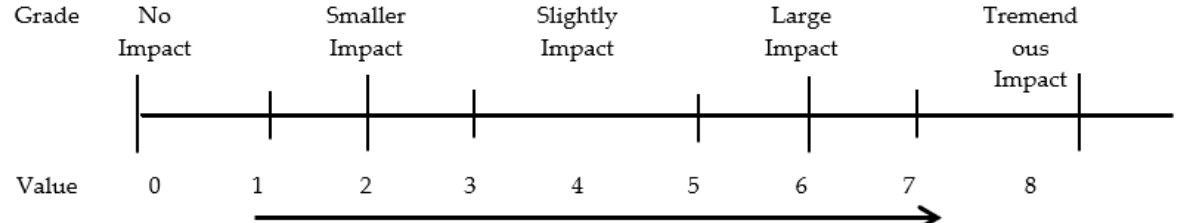
Figure 2. Influence Matrix Value